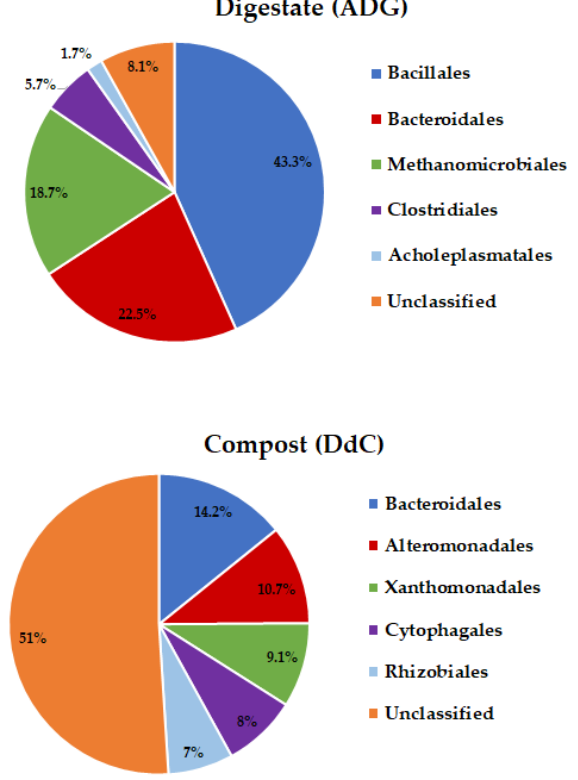
Figure 2. Top 5 bacterial orders identified in digestate (ADG) and a more stabilized digestate-derived compost (DdC) microbiome. The taxonomic profile was identified using sequencing of the amplicons of 16S rRNA gene region. Unassigned 16S sequences were excluded.